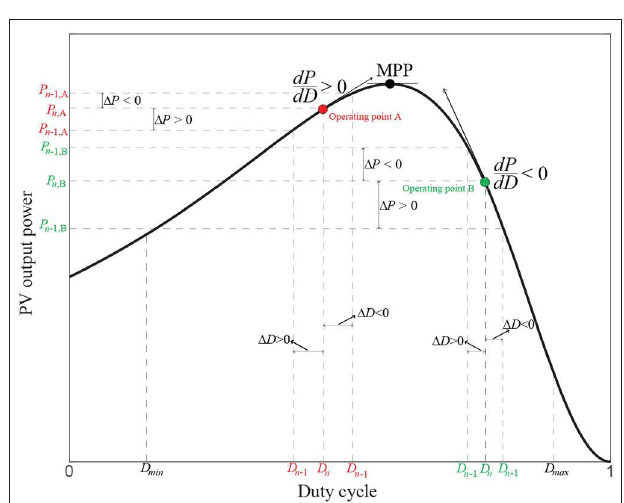
et al., 2013). So the proposed converter is analyzed in CCM mode.